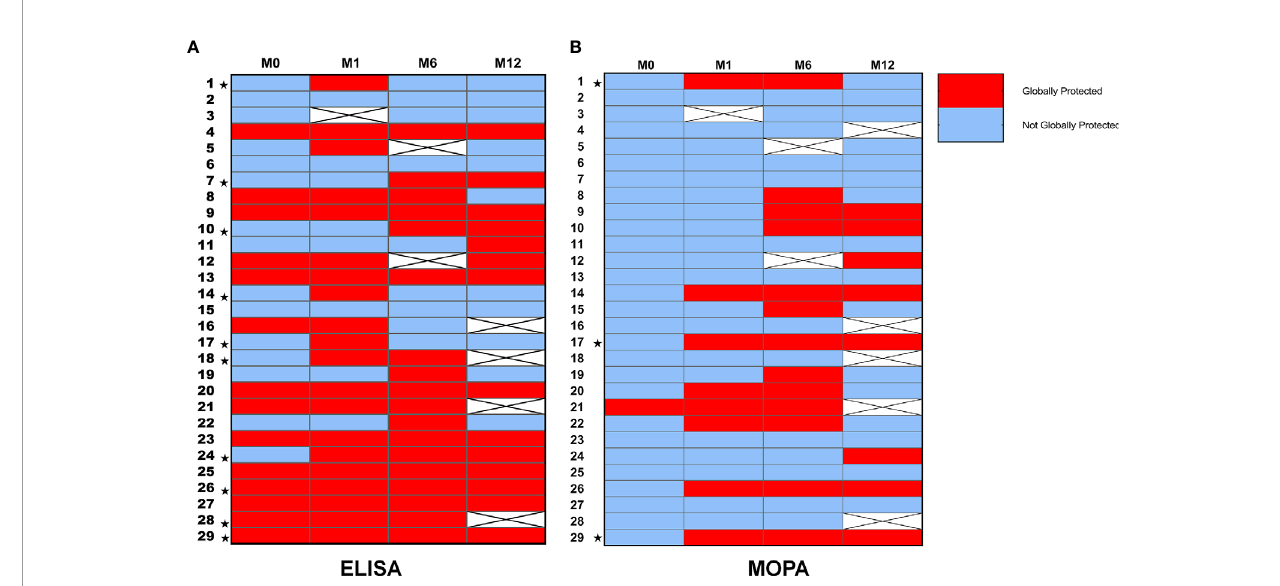
FIGURE 4 | Global response and global protection for every patient. (A) Global protection and global response according to ELISA analyses: Individual data for “ global protection ” are represented in this heatmap. “ Global protection ” based upon ELISA analyses was de fi ned if ≥ 5/8 of serotypes-speci fi c IgG concentrations were ≥ 1µg/mL. Patients considered as “ globally responders ” at one month are signaled with the ★ symbol. “ Global Response ” based upon ELISA analyses was de fi ned if ≥ 5/8 of serotypes-speci fi c IgG concentration had at least a two-fold increase one month after immunization. Missing data are represented as crossed white squares. (B) Global protection and global response according to MOPA analyses: Individual data for “ global protection ” are represented in this heatmap. “ Global protection ” based upon MOPA evaluation was de fi ned if OT ≥ LLOQ was achieved for ≥ 5/7 of tested serotypes. Patients considered as “ global responders ” at one month are signaled with the ★ symbol. “ Global Response ” based upon MOPA evaluation was de fi ned if OT had an at least four-fold increase from baseline one month after vaccination for ≥ 5/7 of tested serotypes. Missing data are represented as crossed white